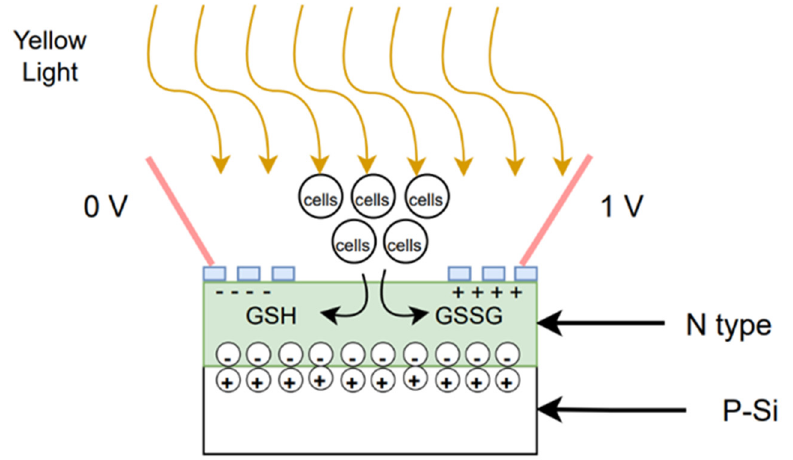
Figure 6. Schematic diagram of the biosensor developed.